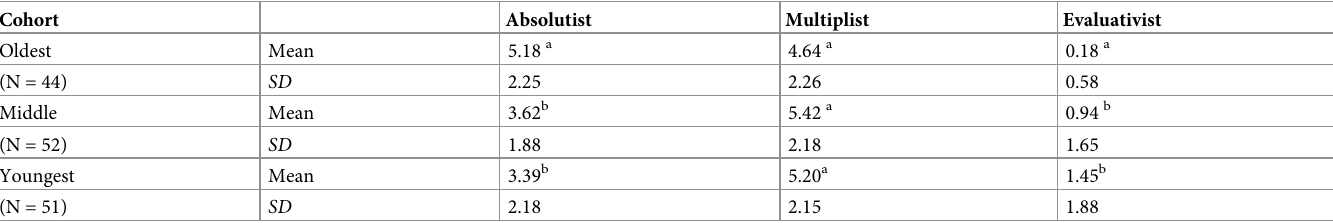
Note . Different superscripts in the same column indicate statistically significant